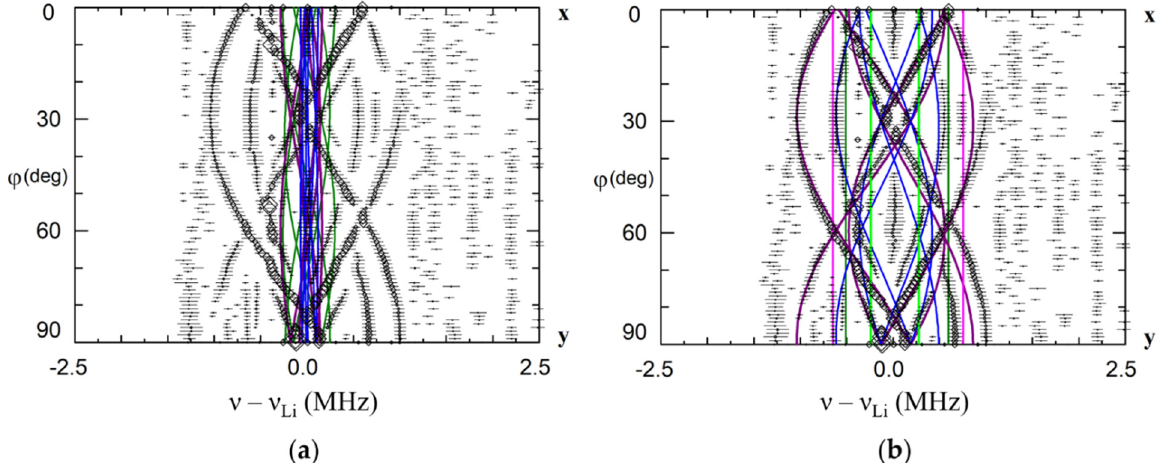
Figure 20. Angular dependence of ENDOR frequencies of Li nuclei in xy plane for the Fe 23+ center in LiTaO 3 . The green, magenta, blue and lime curves—calculated frequencies for Li nuclei of the 1st, 2nd, 3rd and 4th shells based on dipole-dipole interaction for Fe 3+ Li ( a ), and Fe 3+ Nb ( b ). Fuchsia lines on ( b )—calculated frequencies for the additional Li nucleus in the nearest v oct on the axis of Fe 3+ Nb center. ENDOR frequencies represented by rhombs were measured on the EPR line at B = 1162 mT ( ν ≈ 34.5 GHz).